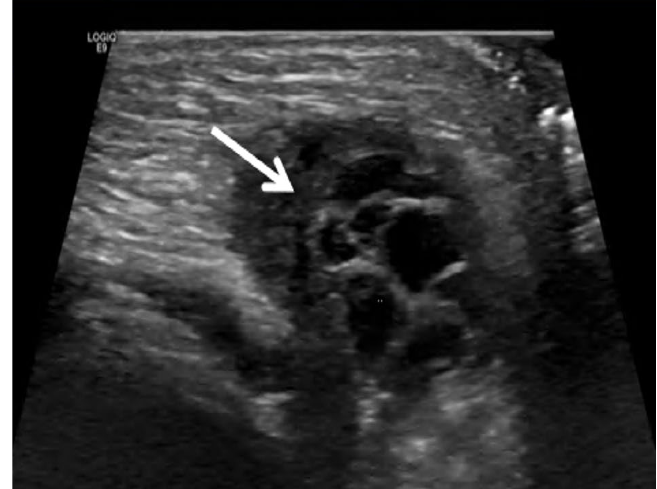
Image 1. Ultrasonography (transverse view) showing an incarcerated ovary (arrow) within an inguinal